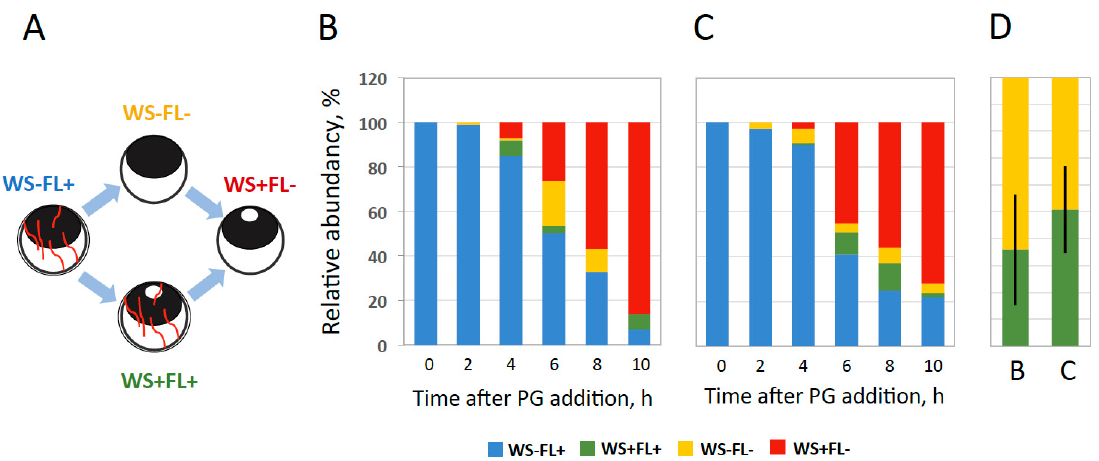
Figure 4. Synchronization of GVBD and follicular rupture during in vitro ovulation. ( A ) Two